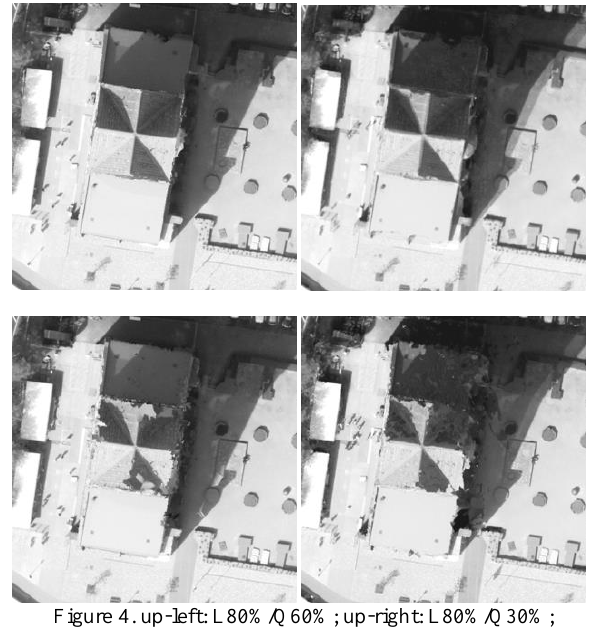
Figure 4. up-left: L80%/Q60%; up-right: L80%/Q30%; down-left: L60%/Q60%; down-right: